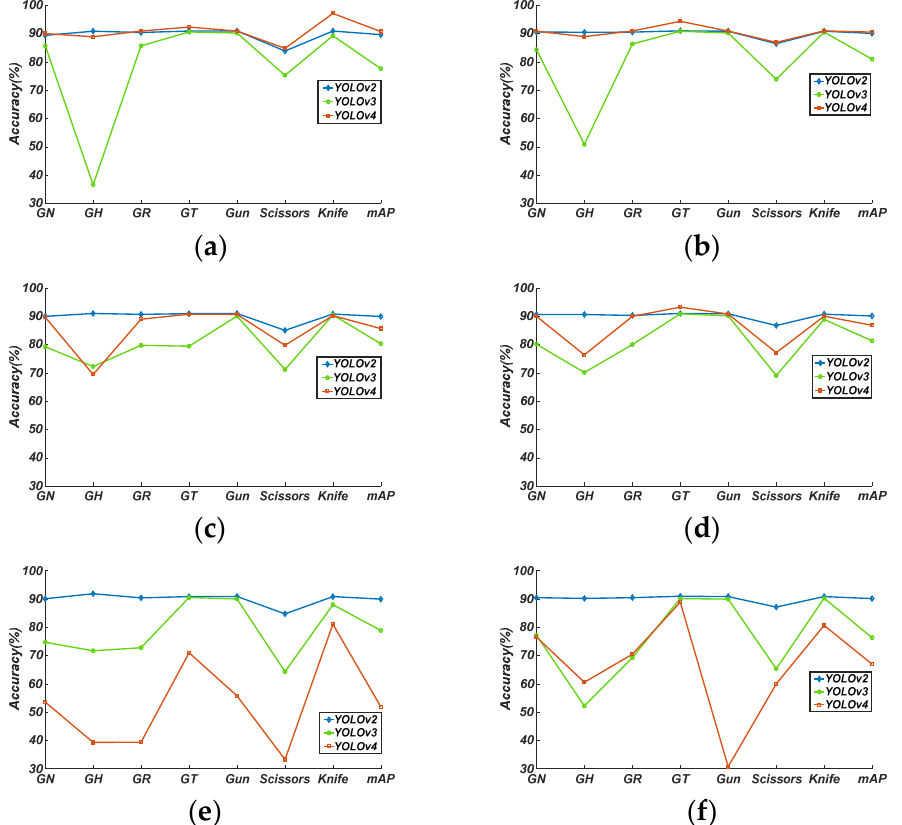
Figure 11. Detection accuracy at different learning rates and numbers of iterations: ( a ) learning rate = 0.001, iterations = 9000; ( b ) learning rate = 0.001, iterations = 14,000; ( c ) learning rate = 0.003, iterations = 9000; ( d ) learning rate = 0.003, iterations = 14,000; ( e ) learning rate = 0.005, iterations = 9000; ( f ) learning rate = 0.005, iterations = 14,000.